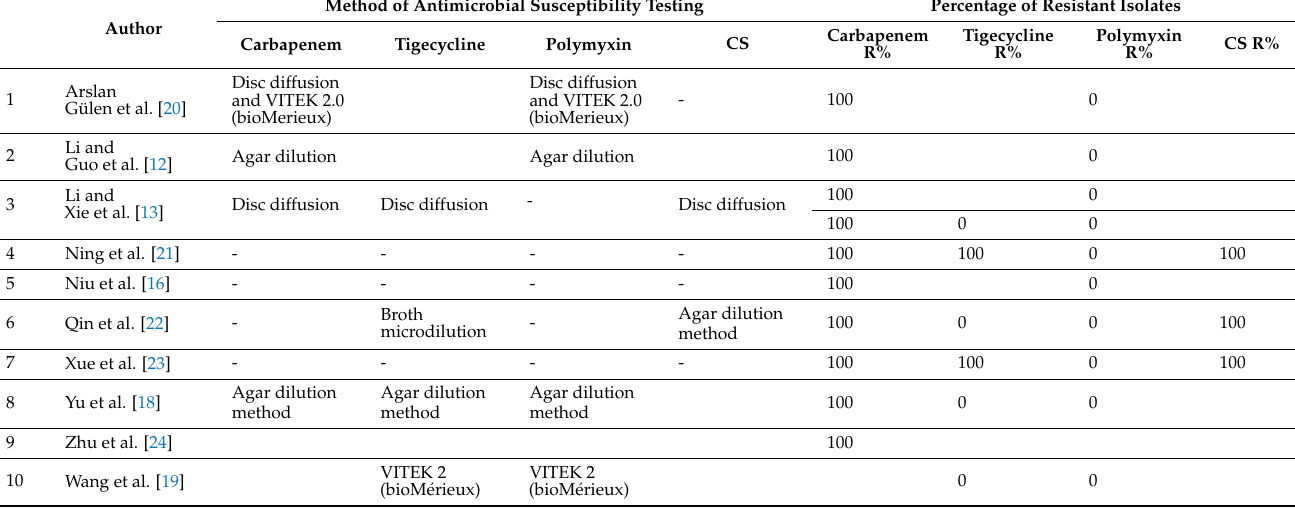
Table 5. Methods of antibiotic susceptibility in studies where cefoperazone-sulbactam was used in combination with colistin or polymyxin, tigecycline, and